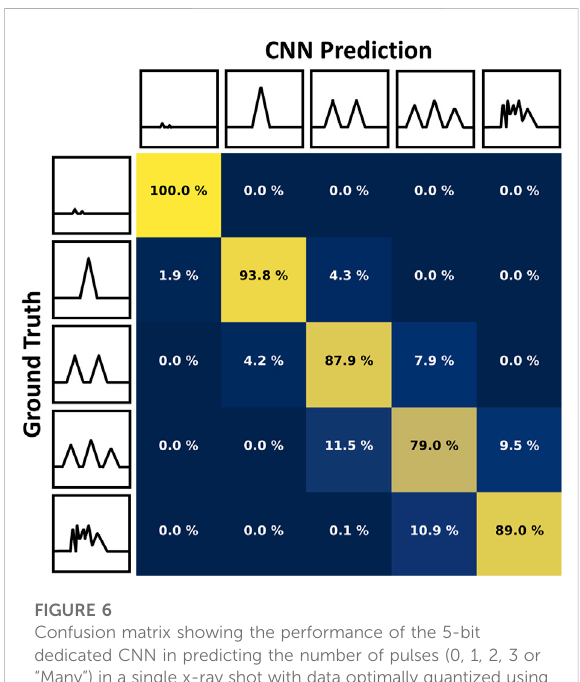
FIGURE 6 Confusion matrix showing the performance of the 5-bit dedicated CNN in predicting the number of pulses (0, 1, 2, 3 or “ Many ” ) in a single x-ray shot with data optimally quantized using 5 bits. A perfect CNN would have 100% (yellow) in every box on the diagonal and 0% (dark blue) everywhere